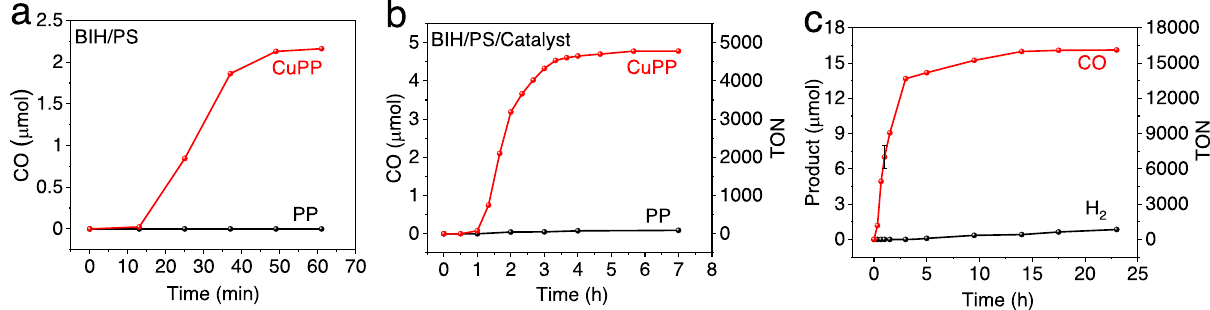
Fig. 5 Photocatalytic CO 2 reduction. Experiments were performed in CO 2 -saturated DMF solution containing a 0.1 mM CuPP (red) or 0.2 mM PP (black), and 100 mM BIH; b 0.2 mM PP (black) or 0.1 mM CuPP (red), 0.2 µ M FeTDHPP, and 10 mM BIH; c 0.1 mM CuPP, 0.2 μ M FeTDHPP, and 100 mM BIH. Error bar (95% con fi dence interval based on three runs) is included at the 1-h point, which is the typical error in the measurement (14%). Source data are provided as a Source Data fi